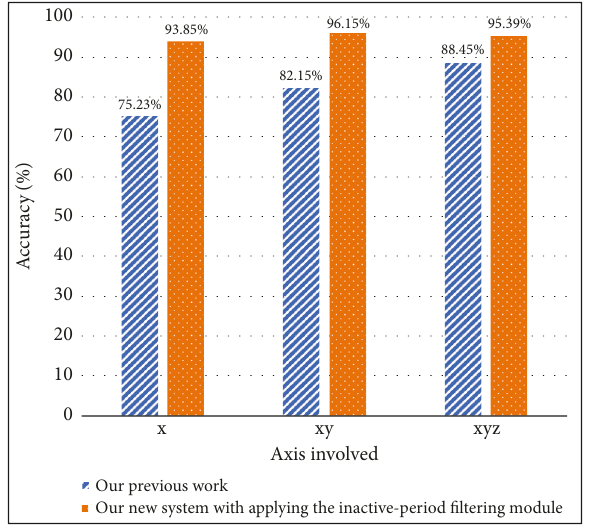
Figure 11: Plot of the accuracy with and without applying the inactive-period filtering module.